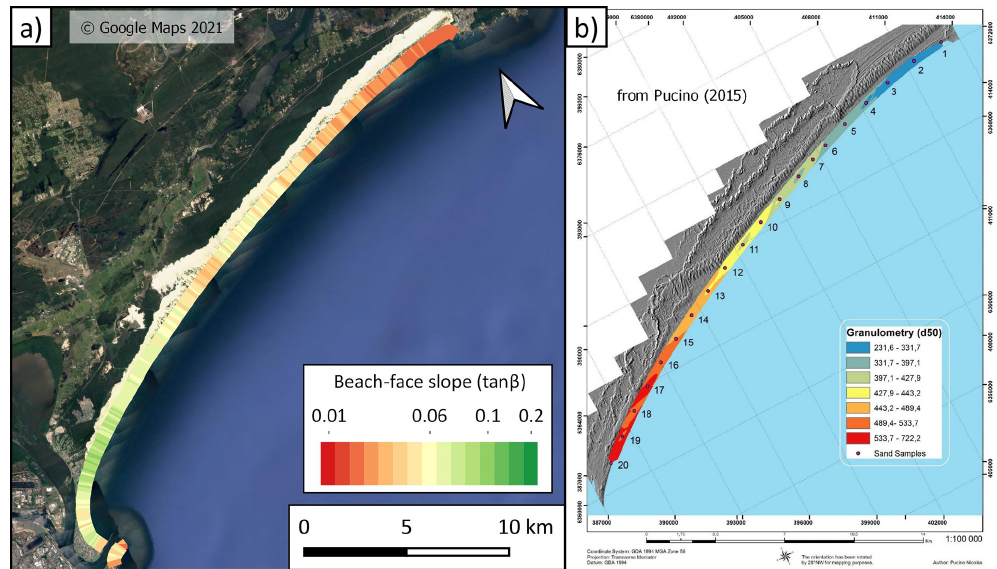
Figure 8. Embayment-scale gradient in beach-face slopes and sediment grain size. (a) Beach-face slope estimates along 100m-spaced cross- shore transects along the Stockton Bight embayment. (b) Figure taken from Pucino (2015) displaying the spatial distribution of median grain size ( D 50 ) for 20 sand samples along the embayment. D 50 values are in microns and have been interpolated using the inverse-weighted distance and discretised into seven